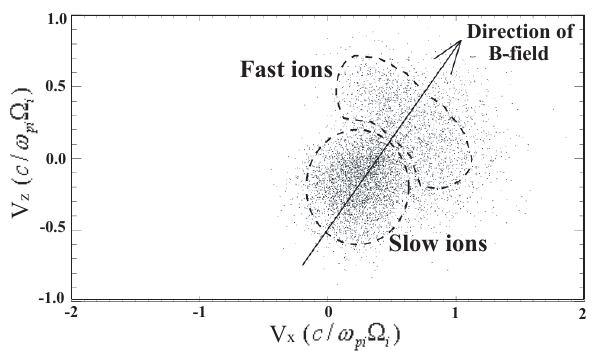
Fig. 3. Scatterplots of ion in-plane velocities. The ion beams come from separate locations, the slow one straddles the discontinuity and other, a fast one, is below the X -line from Shay